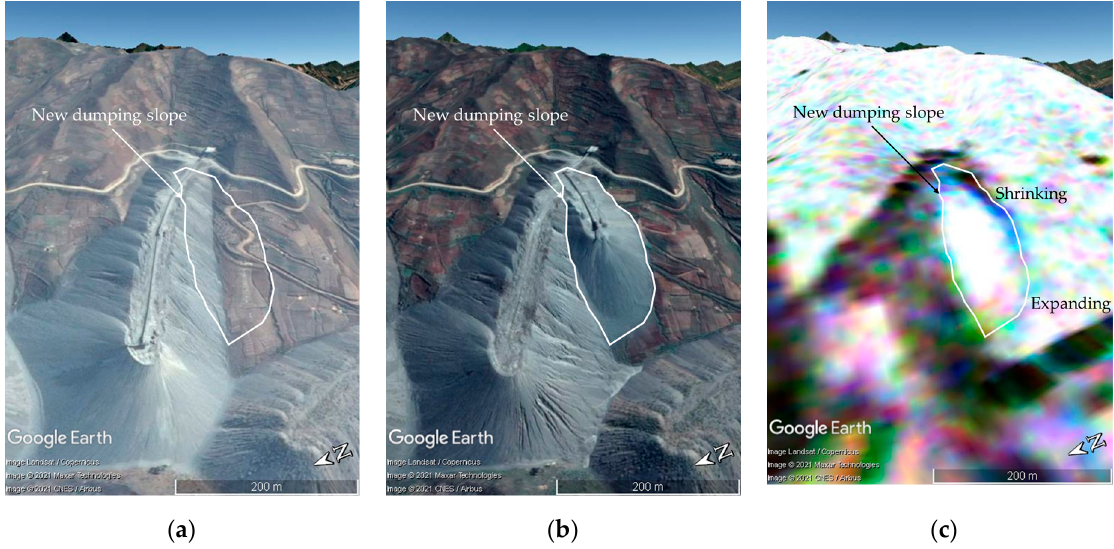
Figure 15. West Dumping Site 2 (WD2). ( a , b ) are Google Earth images taken on 7 October 2015 and 26 September 2019, respectively. ( c ) is the RGB composite of the annually averaged NDAI map (R: 2019, G: 2018, and B: 2017). Solid lines are drawn based on the 2019 Google Earth image.